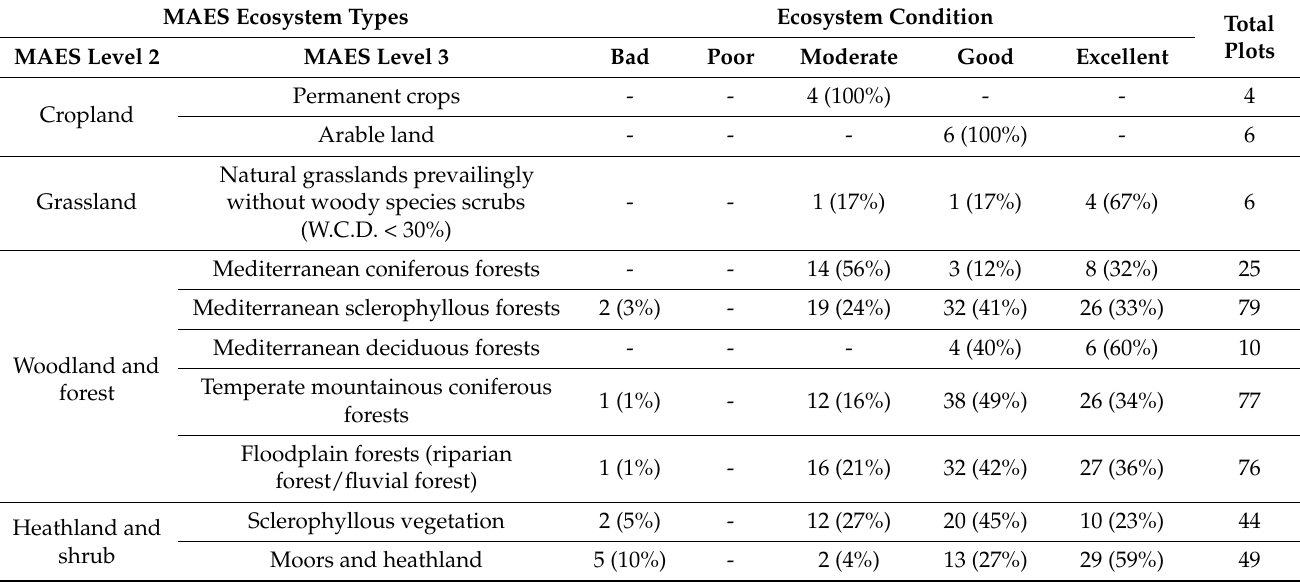
Table 6. Synoptic results for ecosystem condition assessment via field surveys using the MAES_GR online platform [42] at the CVNP.